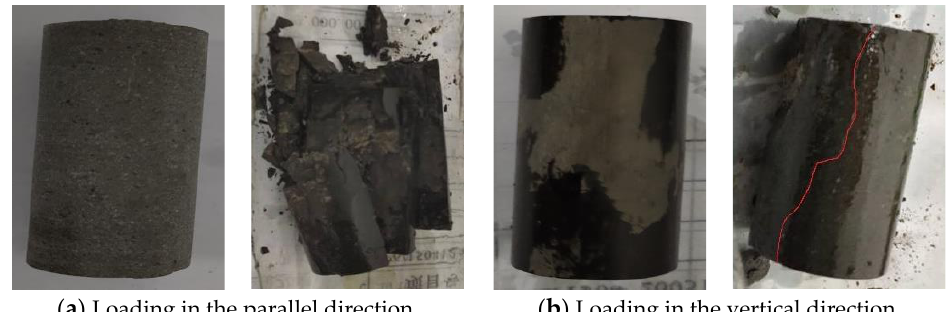
Figure 3. The failure form of shale under different loading directions.